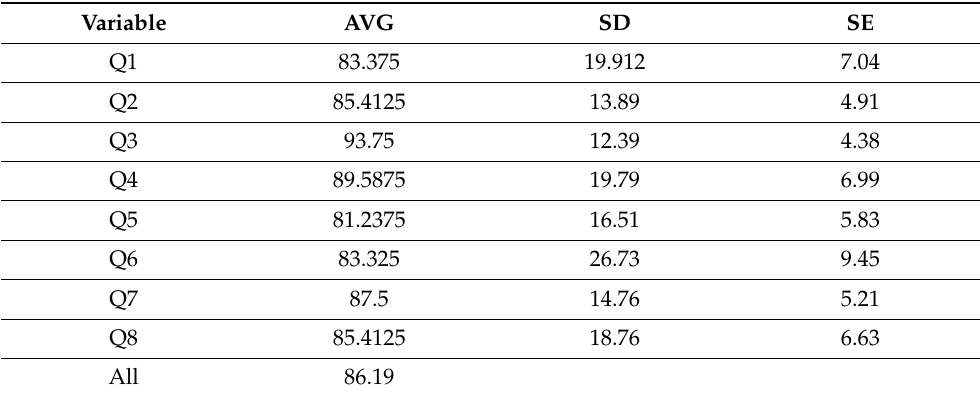
Table 5. Result for usability